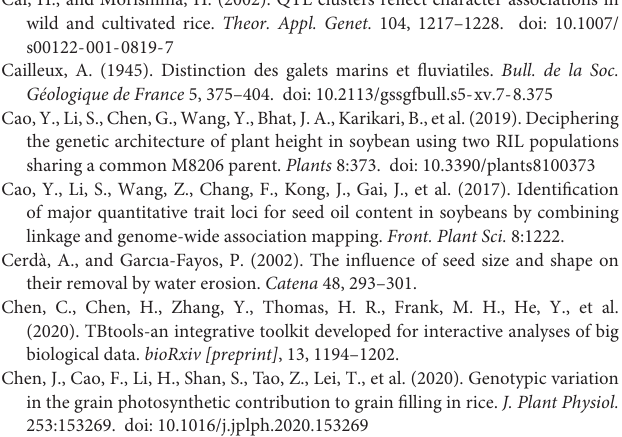
Supplementary Table 2 | Descriptive statistics, variance components, and broad-sense heritability ( h 2 ) of seed shape and size traits evaluated in two